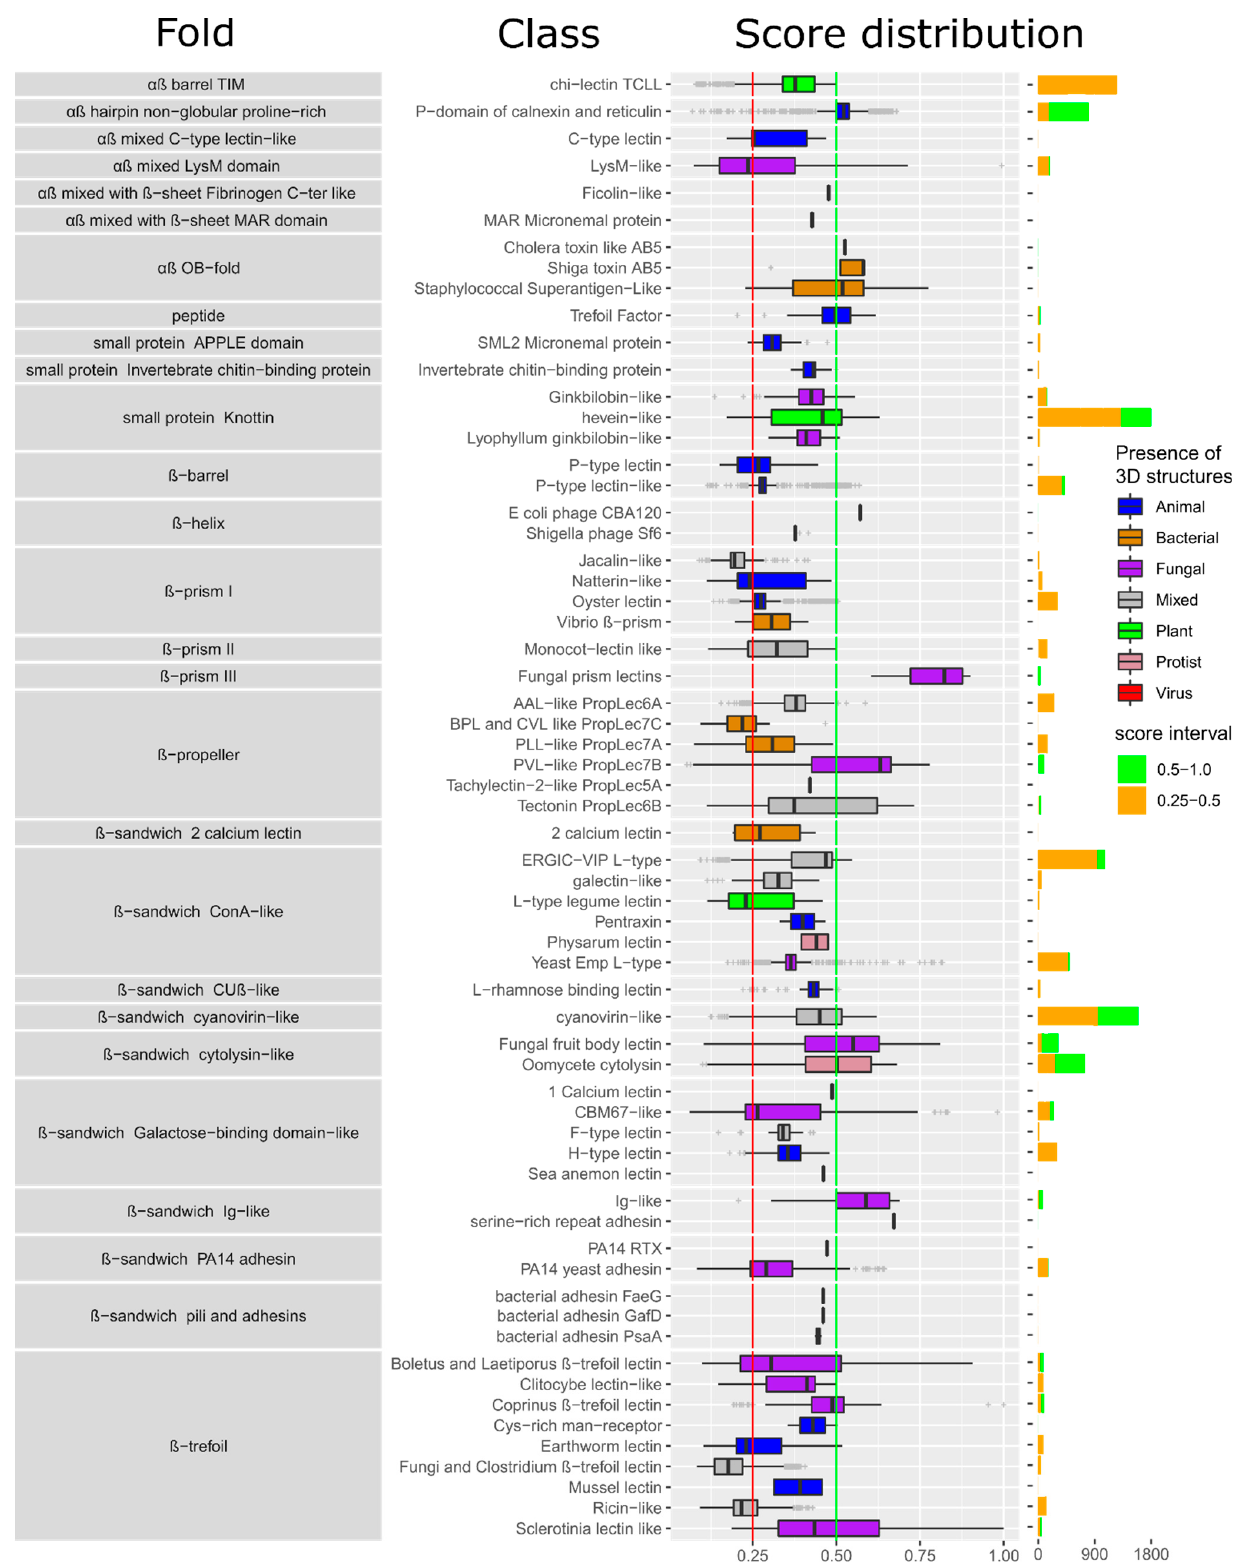
Figure 3. Distribution of the predicted fungal lectins sorted according to their fold and class. Boxplots are colored according to the structural origin of the lectin class defined by 3D structures. The right panel bar chart represents the lectin distribution by class where green represents high confidence (score > 0.5), and orange represents medium confidence predictions (score > 0.25).